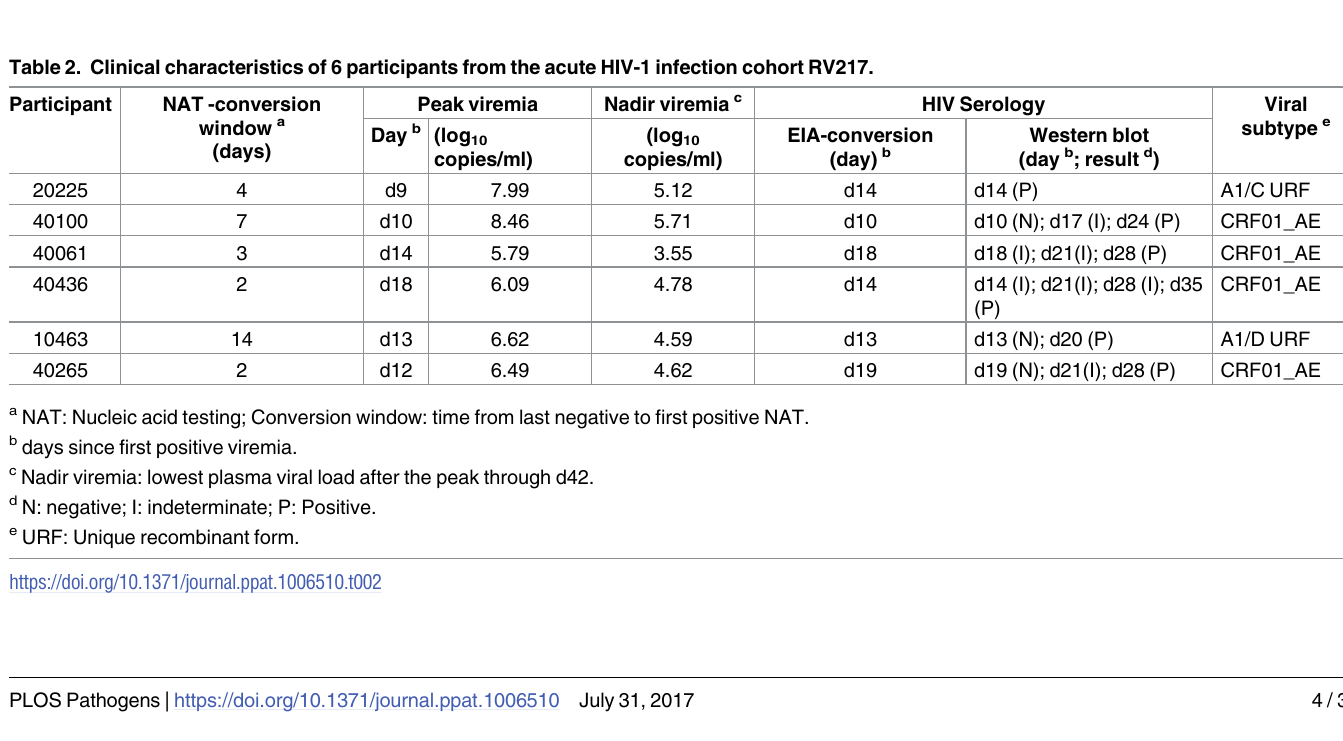
of 3.5 days (range: 2–14 days) (Table 2). By employing twice-weekly sampling (Table 3), viro- logical and serological markers were followed with very high resolution. The pVL and CD4+ cell counts are shown for each case in Fig 1A. Peak viremia (range: 5.79–7.99 log occurred 9–18 days from the onset of viremia. Participants from Thailand were infected with CRF01_AE, while participants from Kenya and Uganda were infected with unique recombi- nant forms of subtype A1 with either subtype C (participant 20225) or subtype D (participant 10463).